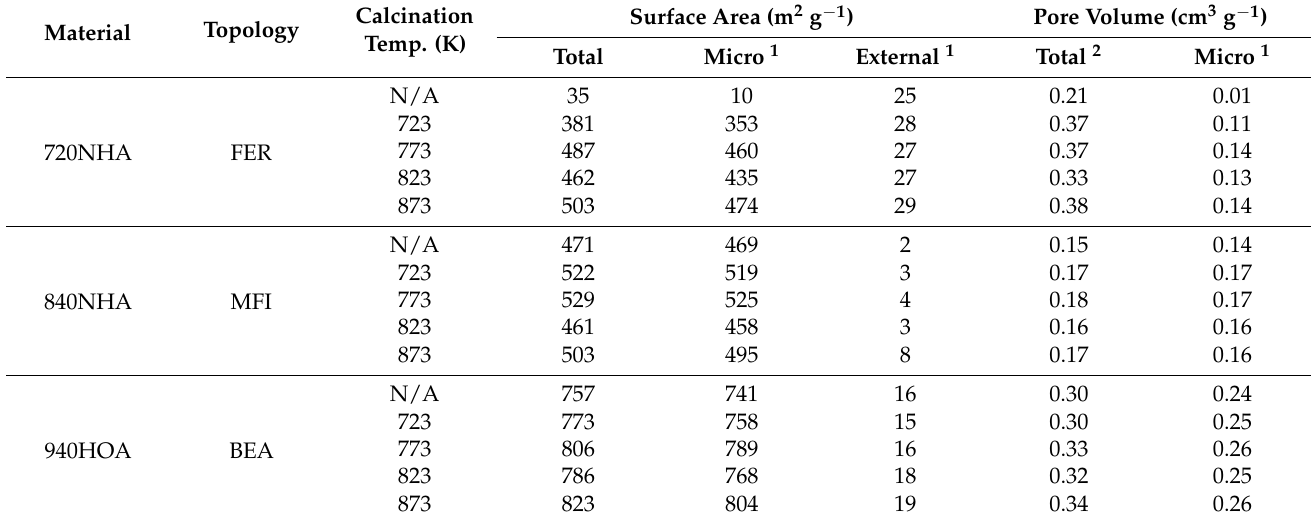
1 calculated using t-plot, 2 calculated using the Brunauer–Emmett–Teller